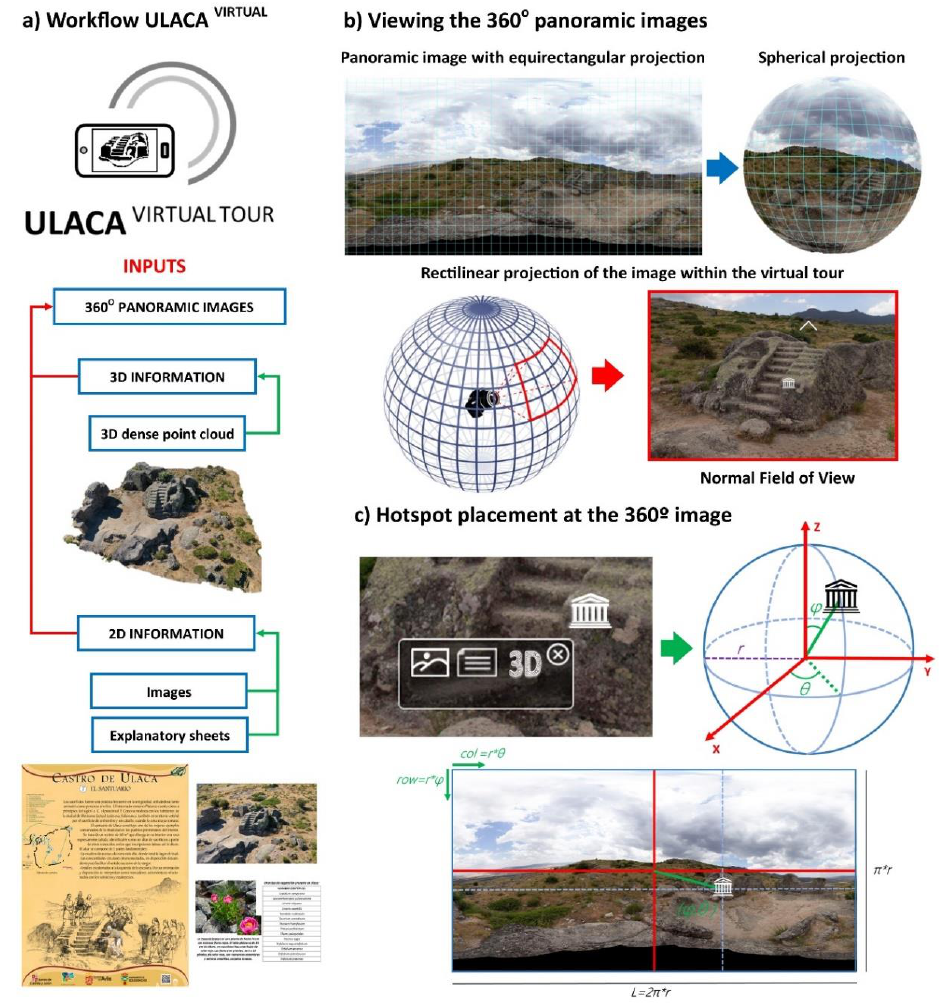
Figure 5. ULACA VIRTUAL TOUR : ( a ) Information about the virtual tour. ( b ) Visualization of the panoramas that integrate the virtual visit. ( c ) Positioning of the information in the panoramas.